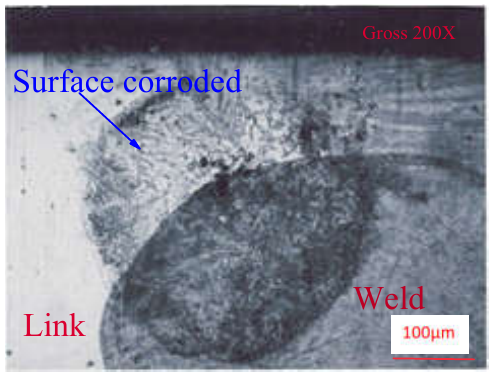
Figure 11. Electrochemical measurement at the laser welding/link H profile interface of the transversal surface (scale = 100 microns). Sample #8.